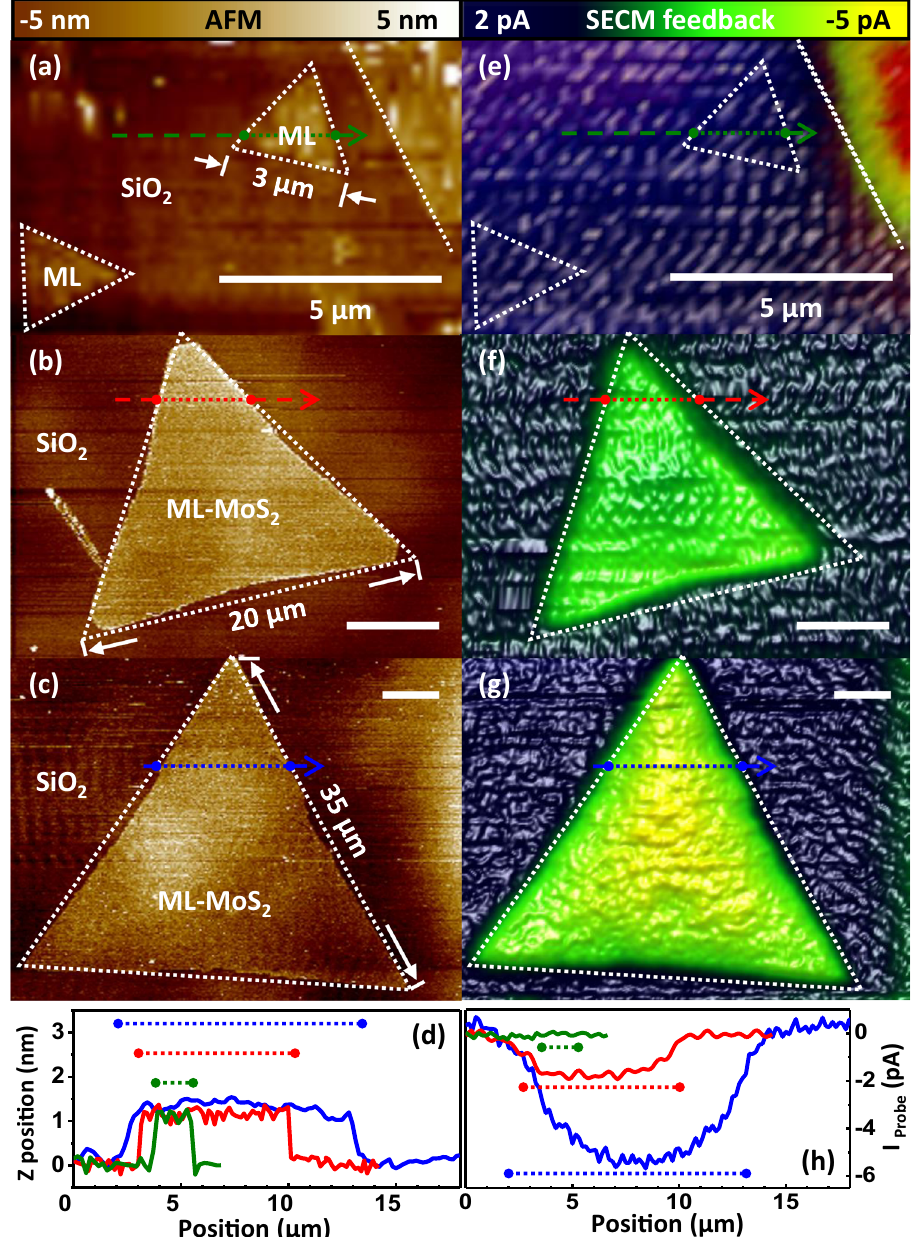
Fig. 2 Size-dependent AFM-SECM feedback mapping of MoS 2 monolayer fl akes. AFM topographs and SECM feedback maps of marked (dotted lines) MoS 2 monolayer fl akes with side length widths of (a , e ) 3 µ m; (b , f ) 20 µ m; ( c , g ) 35 µ m. (Scan rate: 20 µ m/s, V WE-RE (Ag) : 0.6 V, Fc mediator). Color and height scales are identical for all images and the white bars indicate a distance of 5 µ m. d AFM and h SECM cross-sectional height pro fi les along, by respectively color-encoded (green, red, and blue) arrows, indicated paths. The dotted ranges mark the extension of the